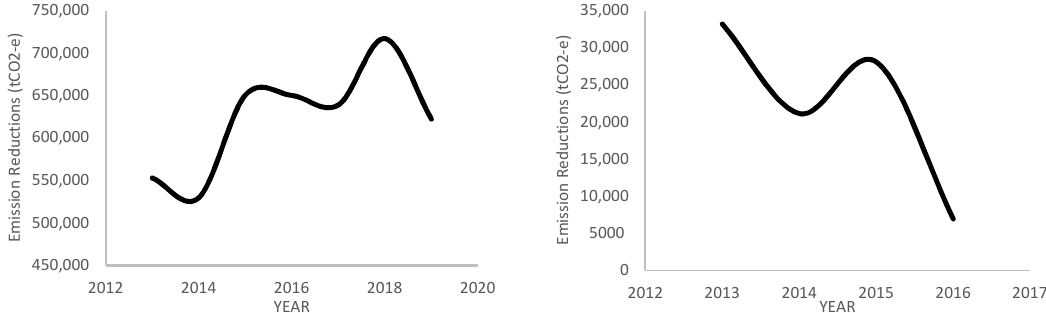
Figure 4. Examples of emission reductions generated by CDM-registered hydropower projects. Top: Data collected from the Dapein (27) Hydropower Project in Union of Myanmar; Bottom: Data collected from the Madushan Hydropower Project on Honghe River in China’s Yunnan Province (Emission reductions data were collected from the project documents, and monitoring reports are available at the CDM project database).